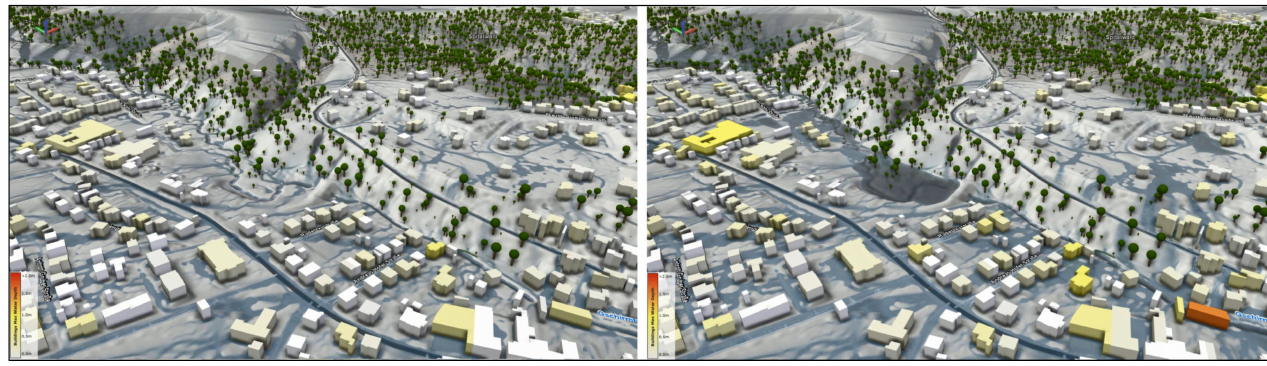
Figure 11. Time-sensitive urban flooding simulation under a heavy rainfall scenario observed from additional angle: earlier time stamp ( left ); later time stamp ( right ). We can further observe how the degree of hazard for potential building structural damage changed for individual building